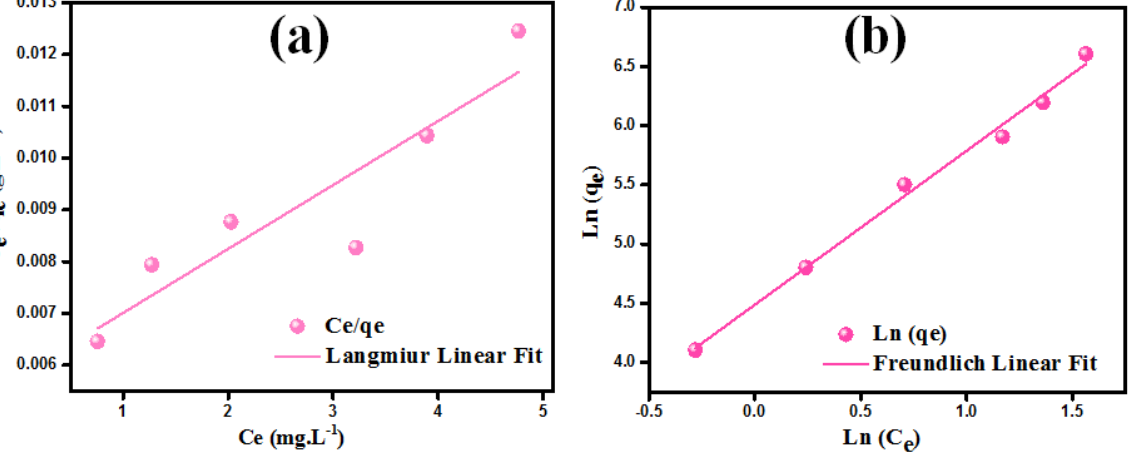
Figure 7. Experimental and fitted adsorption data using the Freundlich ( a ) and Langmuir ( b ) models. As can be noted from the isotherm graphs and the experimental data for BF adsorption over CaO-C 3 N 4 nanosorbent, the Freundlich adsorption isotherm has the highest R 2 = 0.996. These findings indicate that the Freundlich adsorption isotherm curve is more accurate to fit the experimental